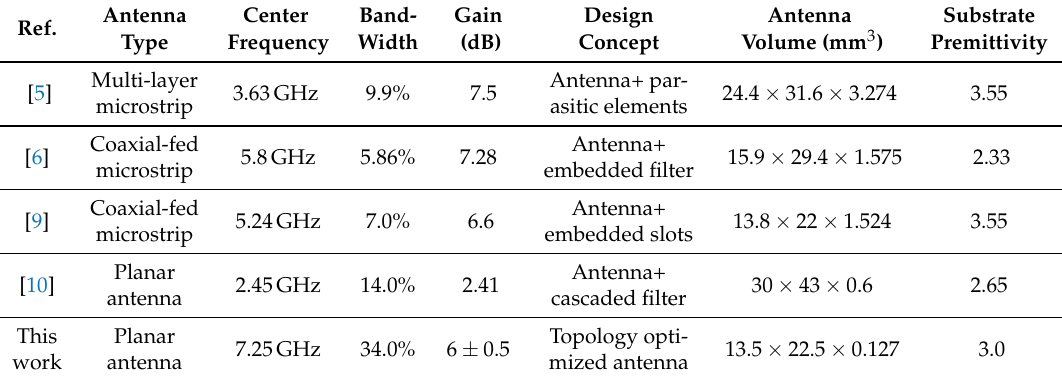
Table 5. A comparison between the current work and previously published work.